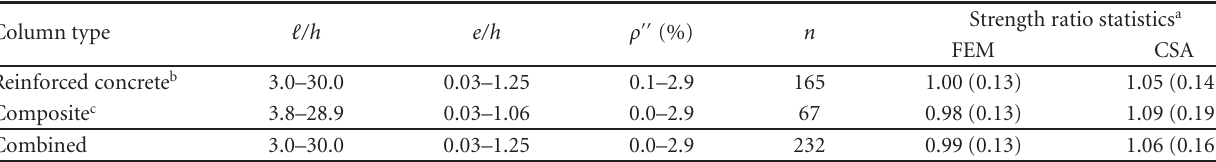
Table 5: Summary of strength ratio statistics for usual reinforced concrete and composite columns (3 < l/h < 30 and 0 < e /h < ∞ ).